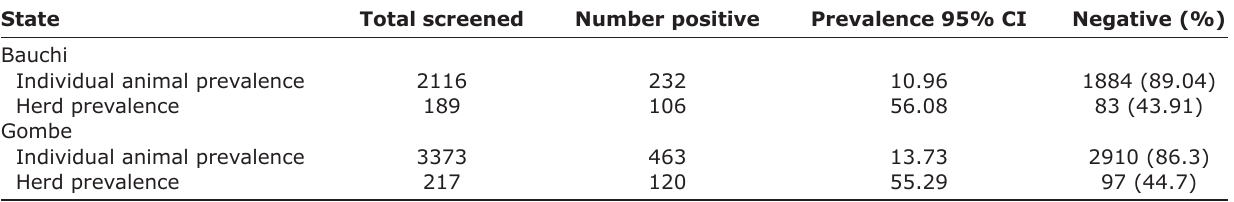
Table-2: Individual animal and herd level prevalence of bovine tuberculosis in Bauchi and Gombe States.